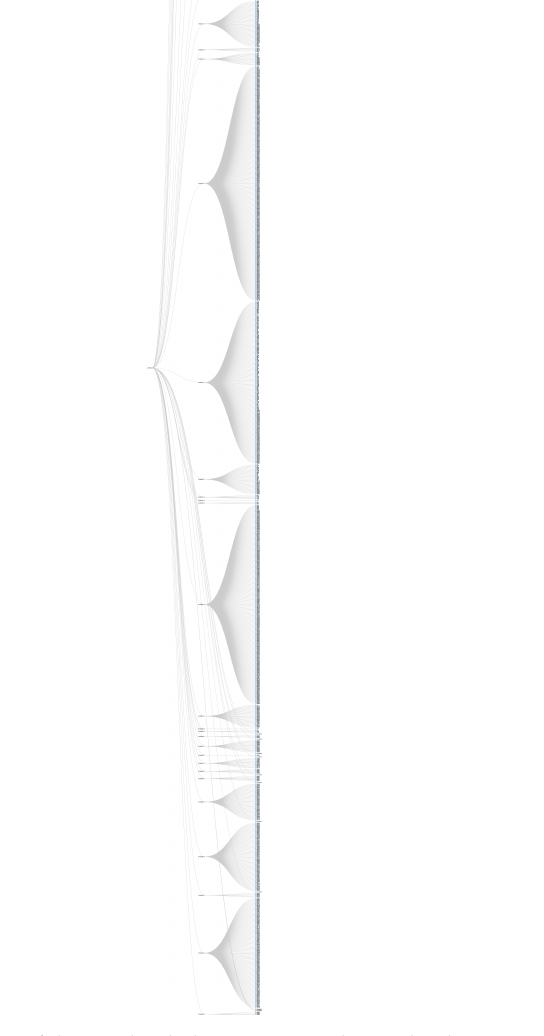
Figure A6. Representation of the Facebook data-set using cluster dendogram